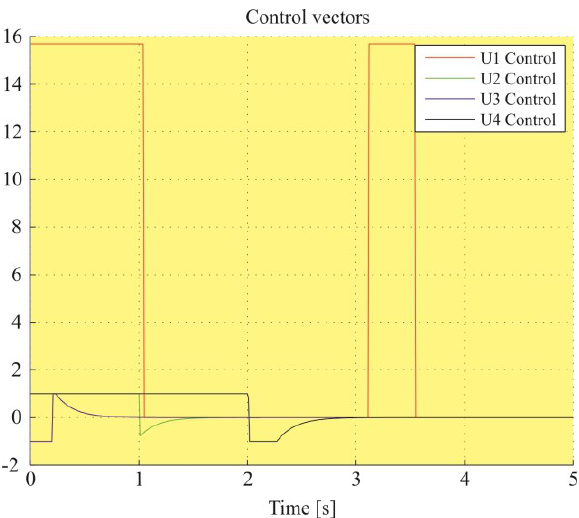
Fig. 5. Components of the control vector from the drive engines